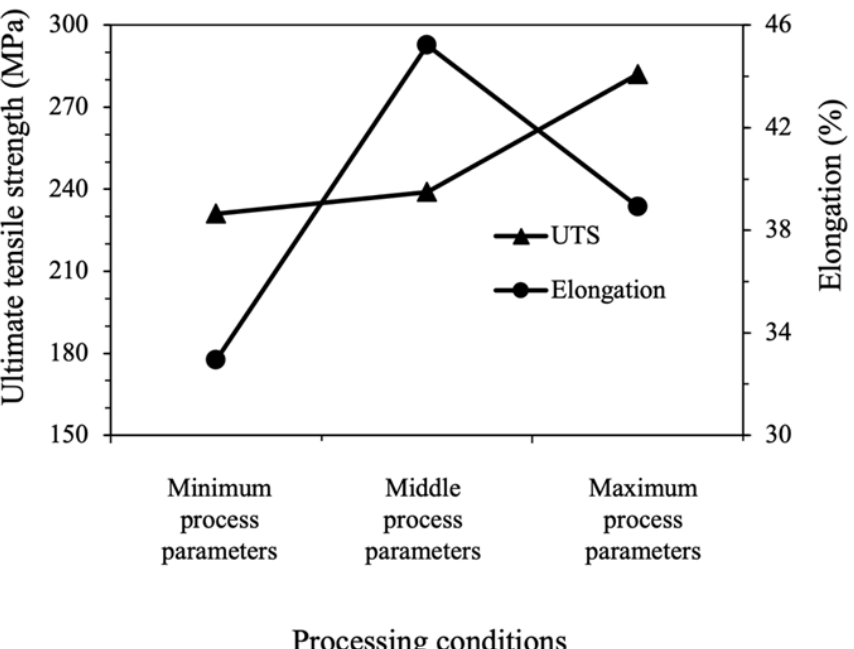
Figure 2. Correlation between UTS and elongation as a function of rotation speed (A) and mechanical milling time (B).